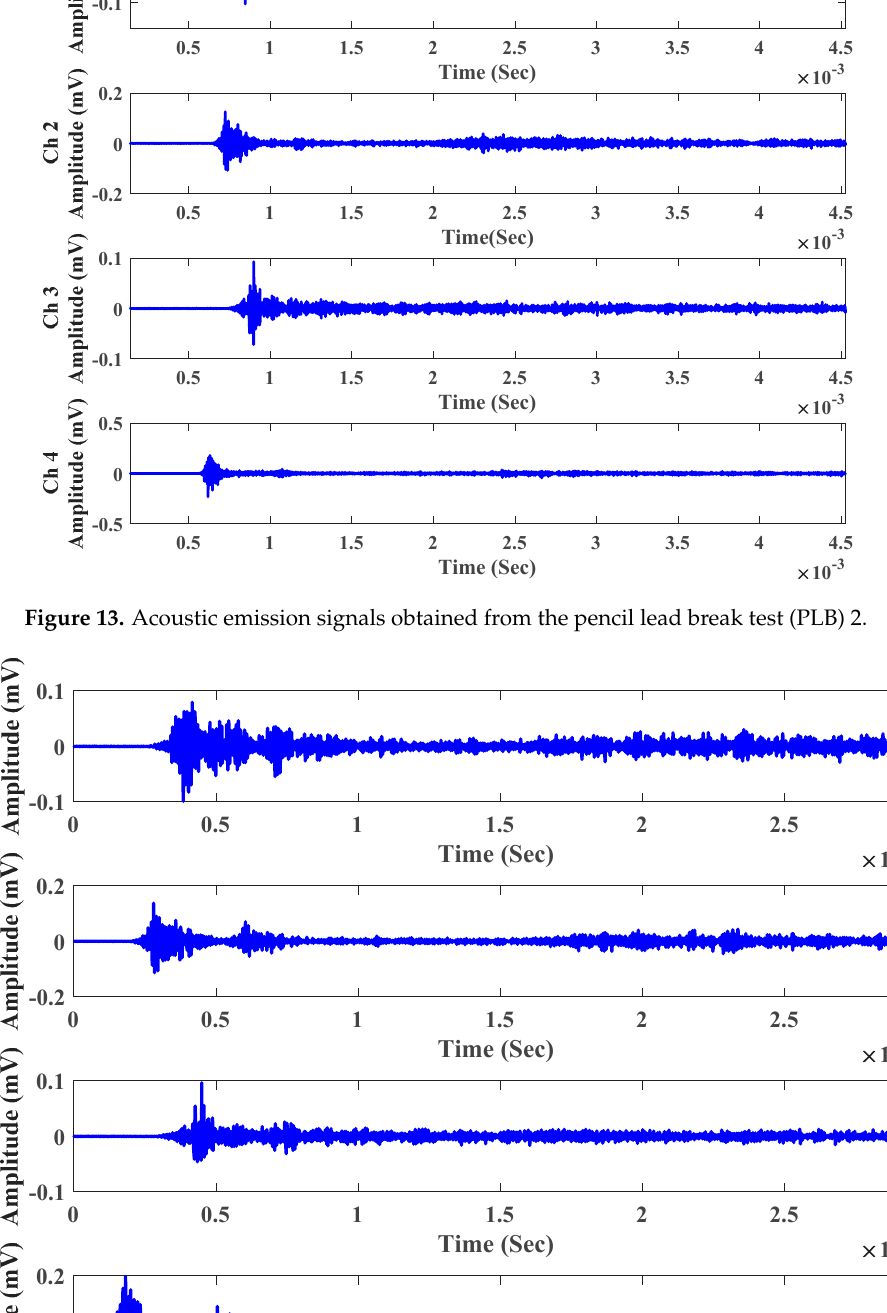
Figure 12. Acoustic emission signals obtained from the pencil lead break test (PLB) 1.